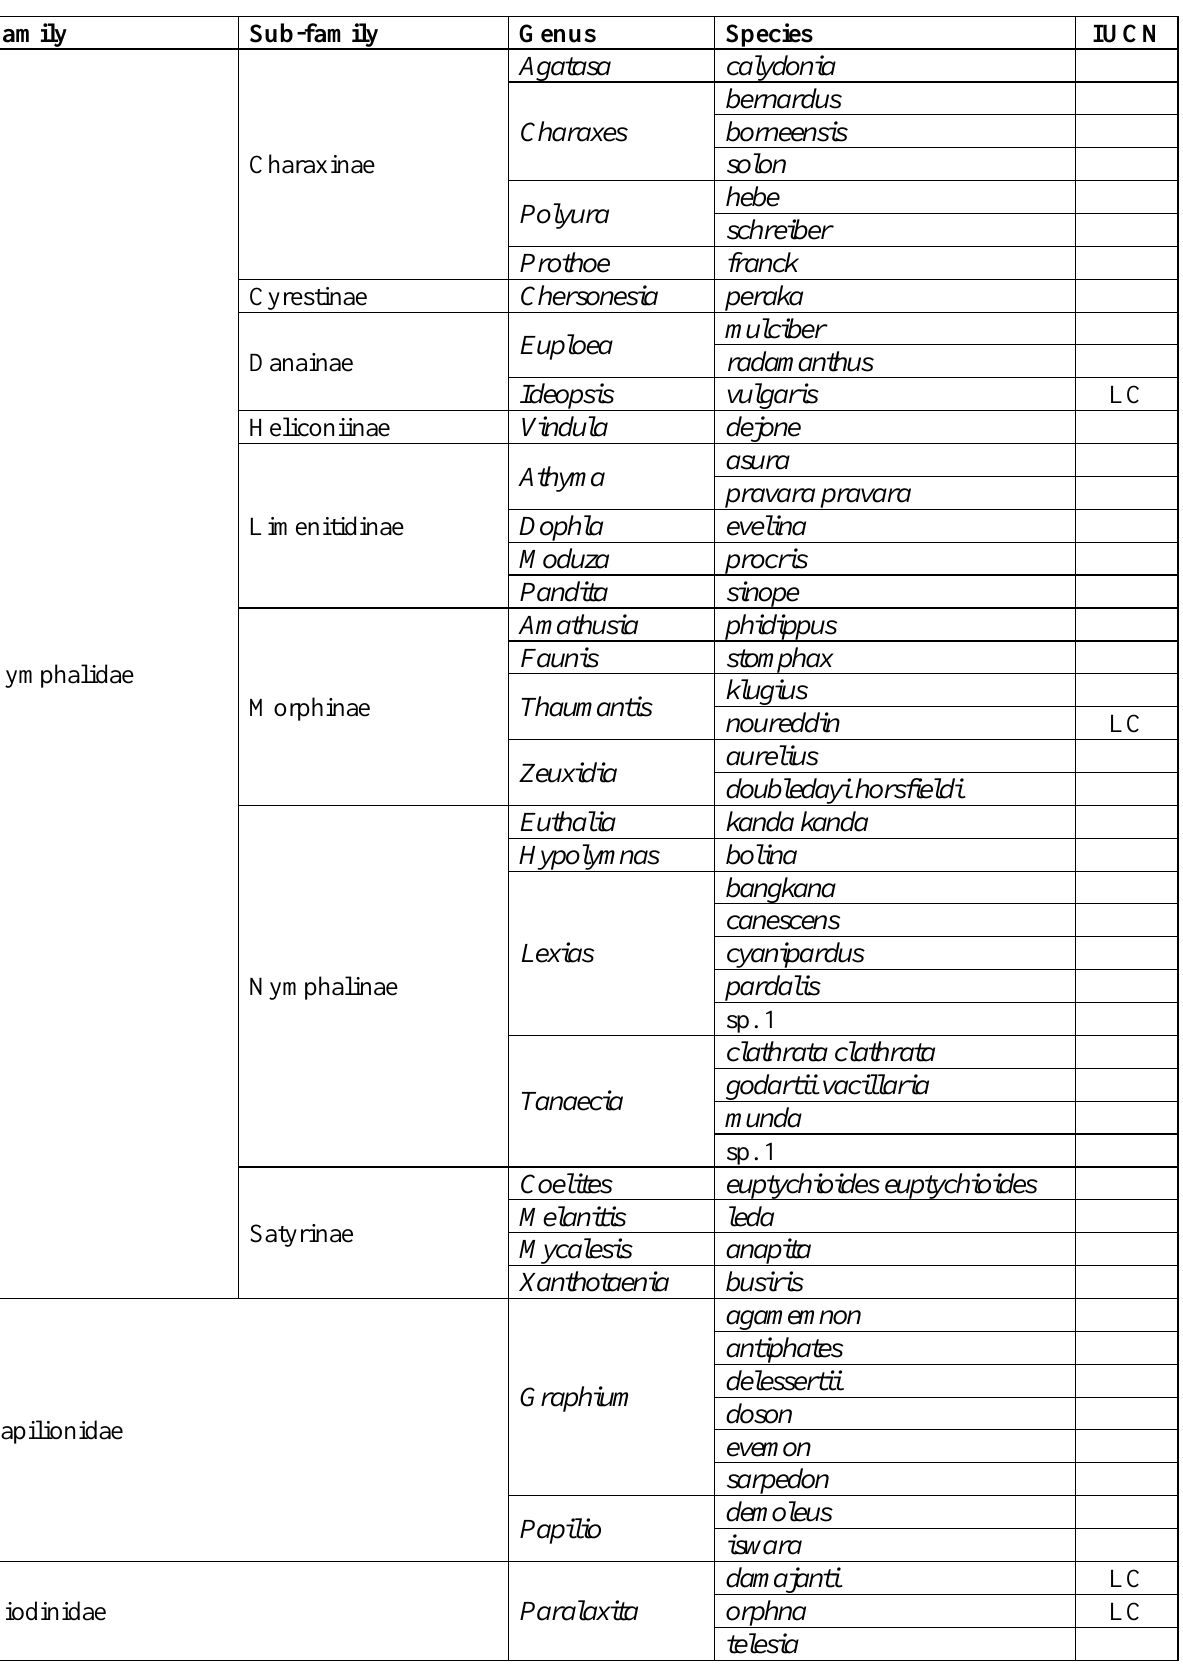
Table A3. List of butterfly (Lepidoptera) species recorded in the NLPSF, Sebangau, together with IUCN Red List classifications (LC = least concern). No species are included on the Indonesian protected species